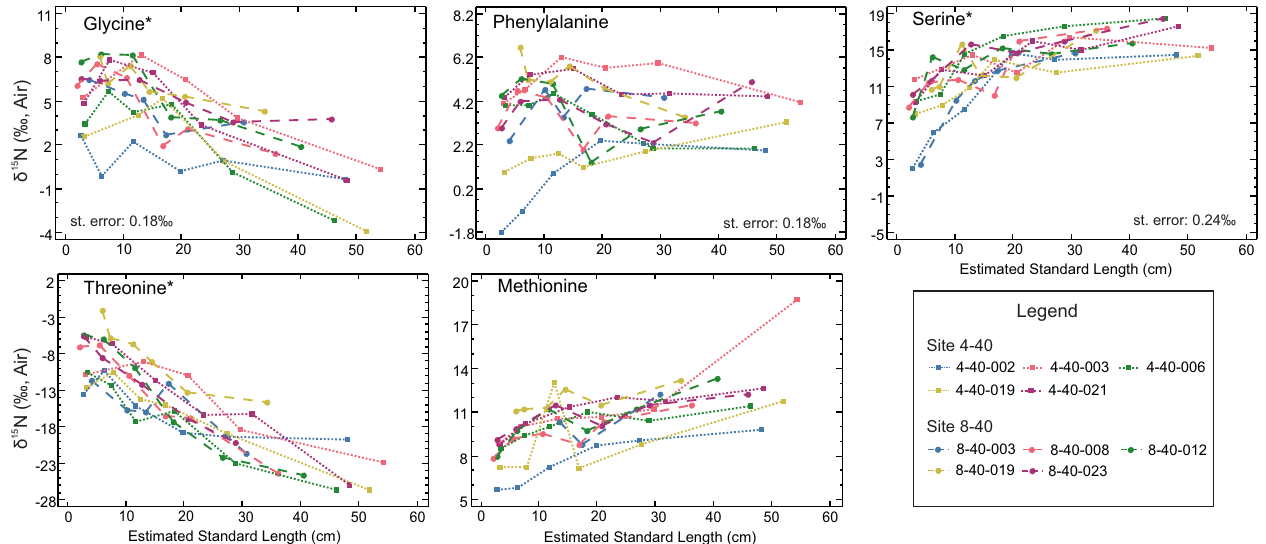
Fig 2. Source and other (indicated by � ) AAs at estimated fish lengths. Each line represents an individual. Squares are Red Snapper from 4–40 and circles are Red Snapper from 8–40. Standard error is from Table 1. Not all AAs have a standard error because not all AA present in eye lens protein were able to be measured in muscle protein.